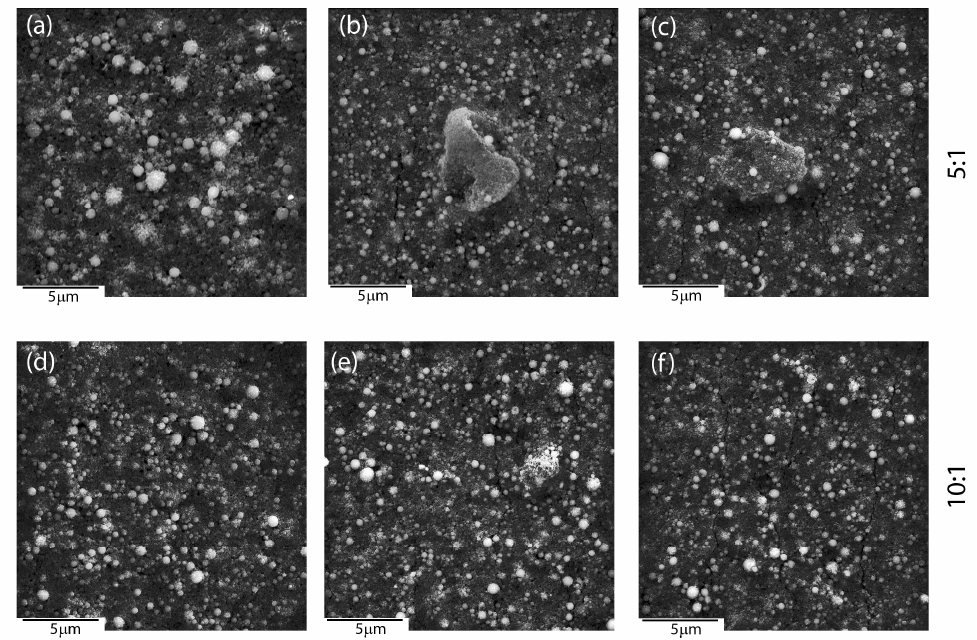
Figure 9. SEM image of the surface of the 5:1 ( a – c ) and 10:1 ( d – f ) HAp / nSiO 2 / Ag layer sintered at 700 ◦ C / 2 h after deformation.